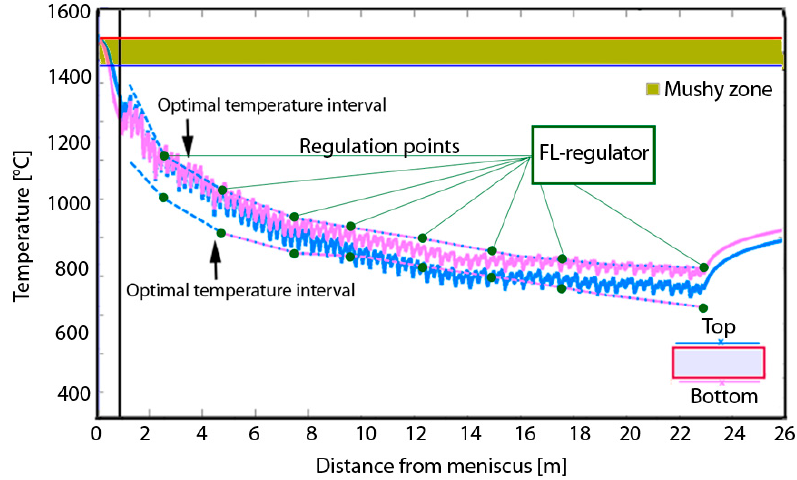
Figure 4. Optimal temperature intervals.